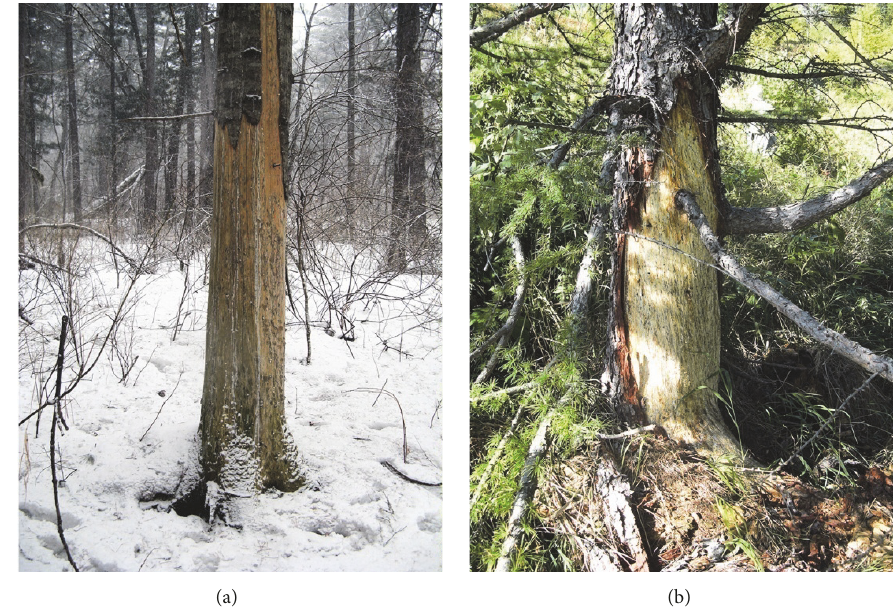
Figure 2: Coniferous trees, bark stripped by bears to get the cambium in Primorsky Krai: (a) Abies nephrolepis and (b) Larix dahurica .